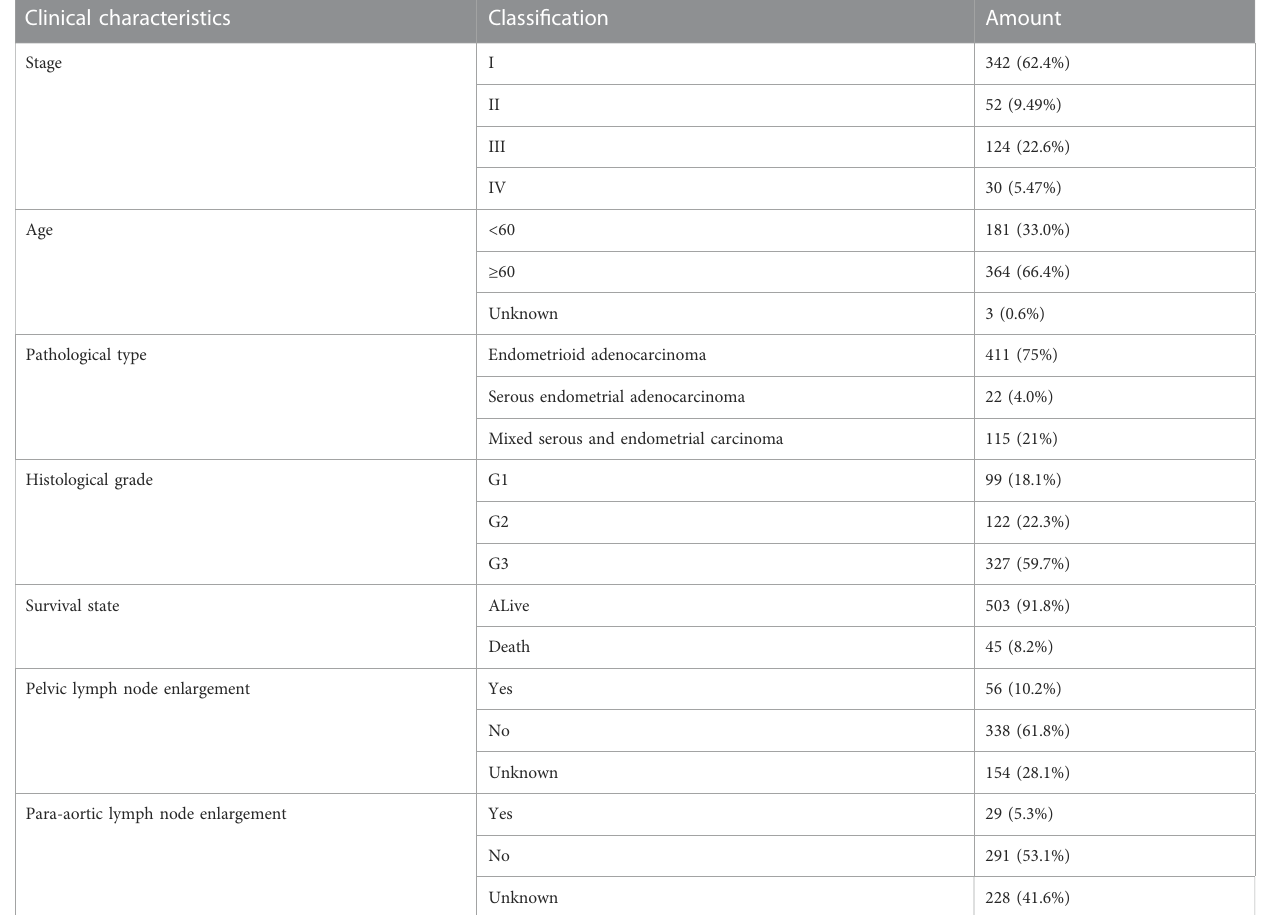
TABLE 1 Clinical characteristics of UCEC patients involved in the study. Clinical